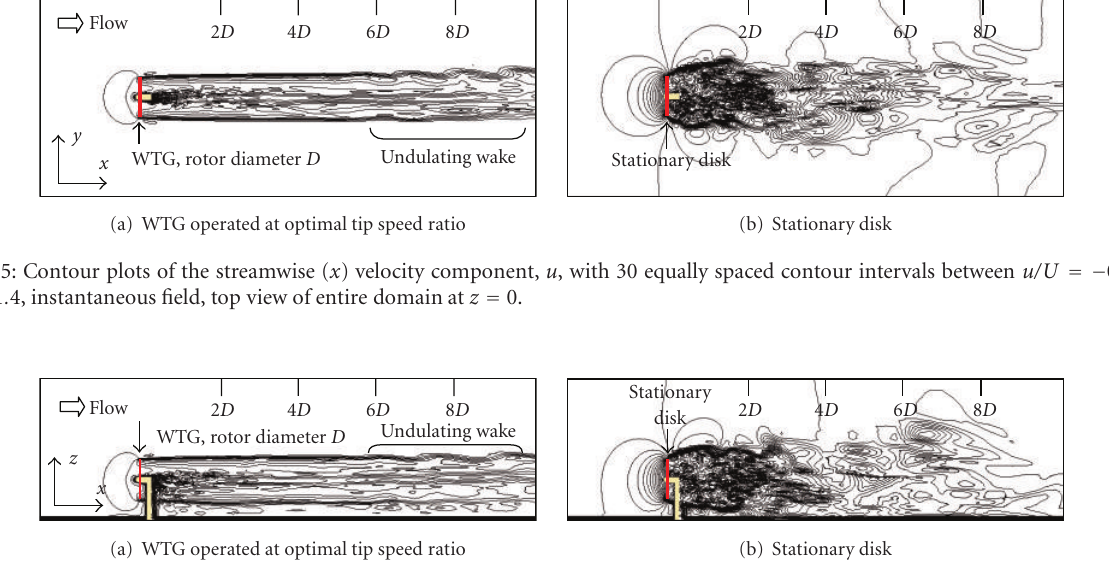
Figure 6: Contour plots of the streamwise ( x ) velocity component, u , with 30 equally spaced contour intervals between u/U = − 0 . 7 and u/U = 1 . 4, instantaneous field, side view of entire domain at y =